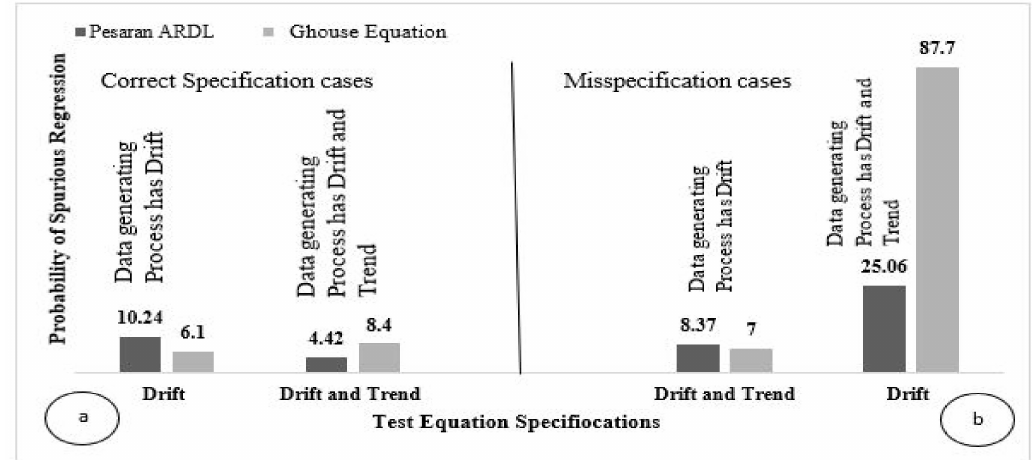
Figure 3. The size comparison between Pesaran ARDL and the Ghouse equation. ( a ) the results of correct specification cases; ( b ) the results of